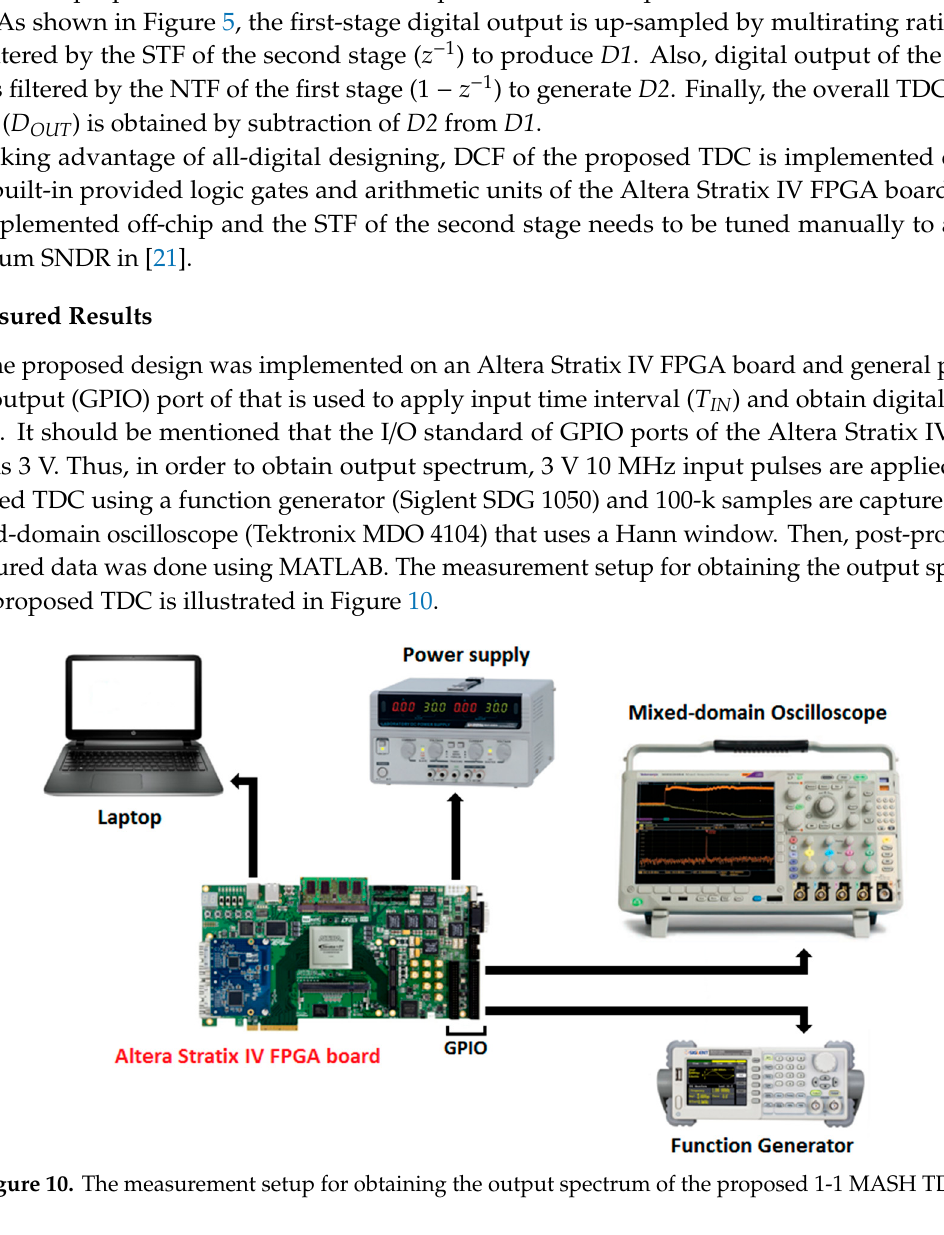
Figure 9. Delaying rising edges of Y2 to avoid error: ( a ) schematic of delayed pulse generator; ( b ) timing diagram.